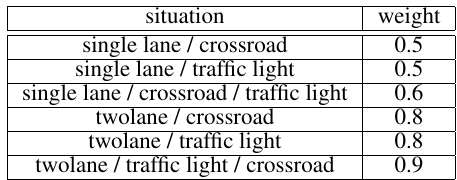
Table 1. Influence of traffic lights or intersections modelled by a weight parameter. If the vehicle is close to a traffic light and a crossroad, the im- pact is higher than with only one existing influence. In addition, of two lanes, the road section is more heavily used and the in- fluence of a traffic light or intersection is consequently higher.